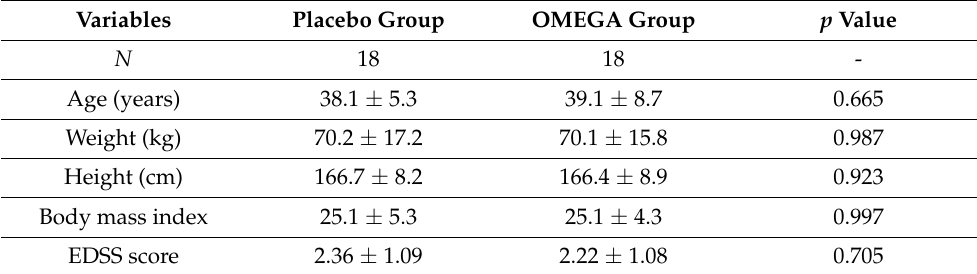
Figure 1. Flow of participants through the study. Table 1. Patient demographic and baseline